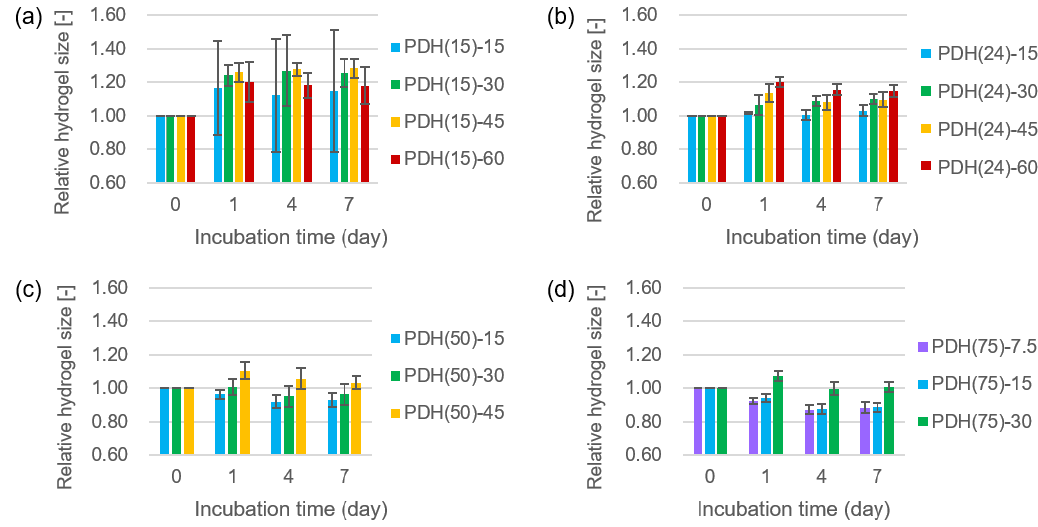
Figure 3. Relative size change of the photodegradable hydrogels with different compositions for 7 days. The hydrogels with compositions listed in Table 1 were prepared with azide-gelatin(15) ( a ), azide-gelatin(24) ( b ), azide-gelatin(50) ( c ), and azide-gelatin(75) ( d ). Error bars represent standard deviations of the relative hydrogel size ( n = 4).